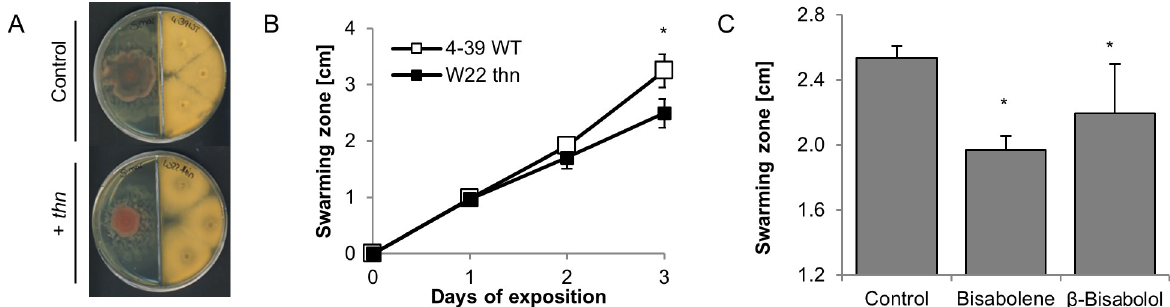
Fig 4. Effect of sesquiterpenes on S . marcescens swarming motility. (A) Setup of experiment, (B) effect of fungal co-cultivation and (C) exposure to (-)-(1 R ,2 S ) β -bisabolol (40 m l -1 ) and bisabolene (0.6 mg l -1 ) on swarming motility of S . marcescens . P < 0.05, n = 3.